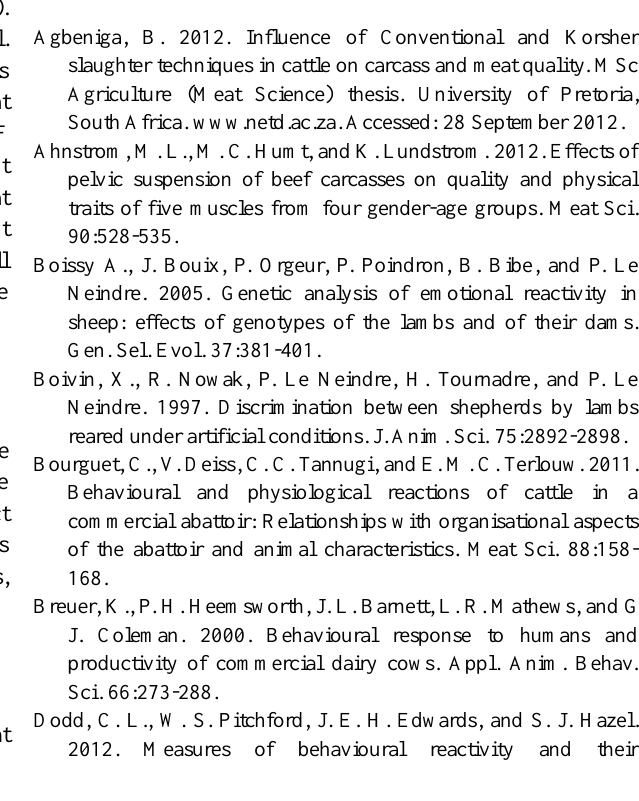
Yellowness (b*) Cooking loss (%) WBSF (N) * Means in the same row with different superscripts are significantly different at